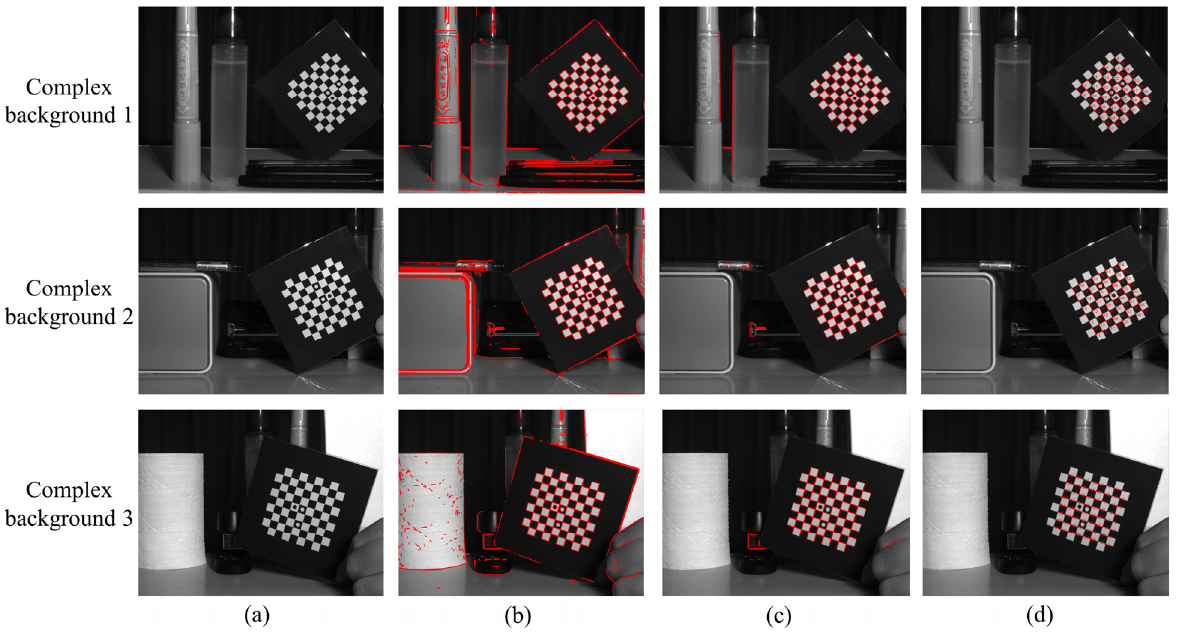
Figure 9. Detection of corner points under complex background: ( a ) original image before detection, ( b )straight-line detection result, ( c ) result after straight-line screening, and ( d ) result after sorting corner points. Table 2. Background straight-line filter